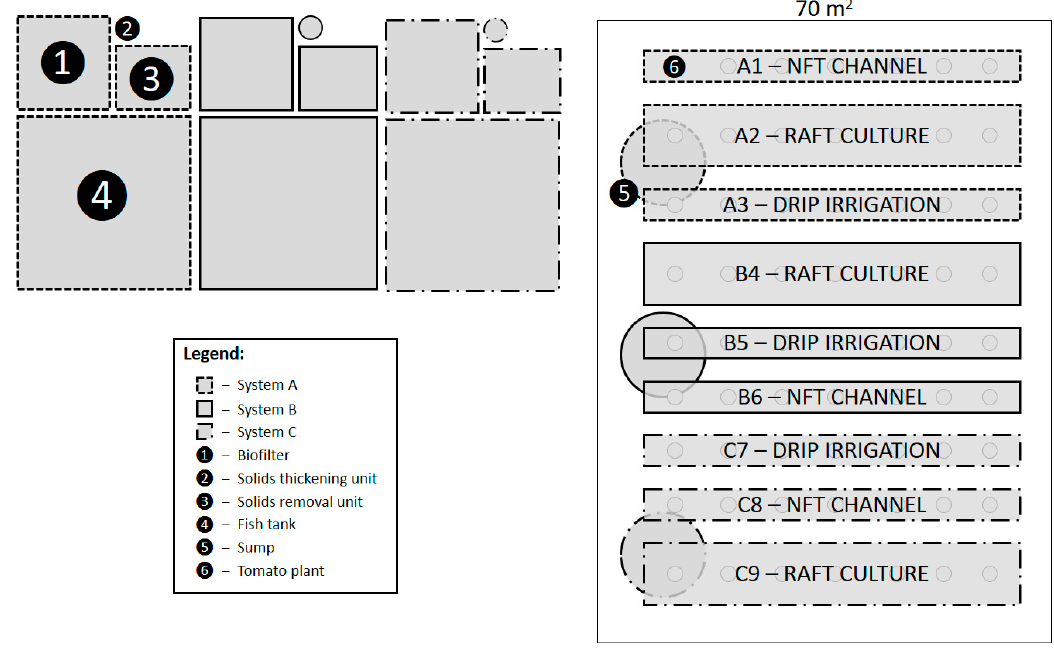
Figure 1. Plan of the experimental subunits in the aquaponic laboratory, from 31 March to 5 November 2014, with three replicates (A, B, and C) at the Zurich University of Applied Sciences in Wädenswil, Switzerland. Framing line style indicates which subunit is connected to which component. While the elements are drawn to scale, the distances between them are not to scale.